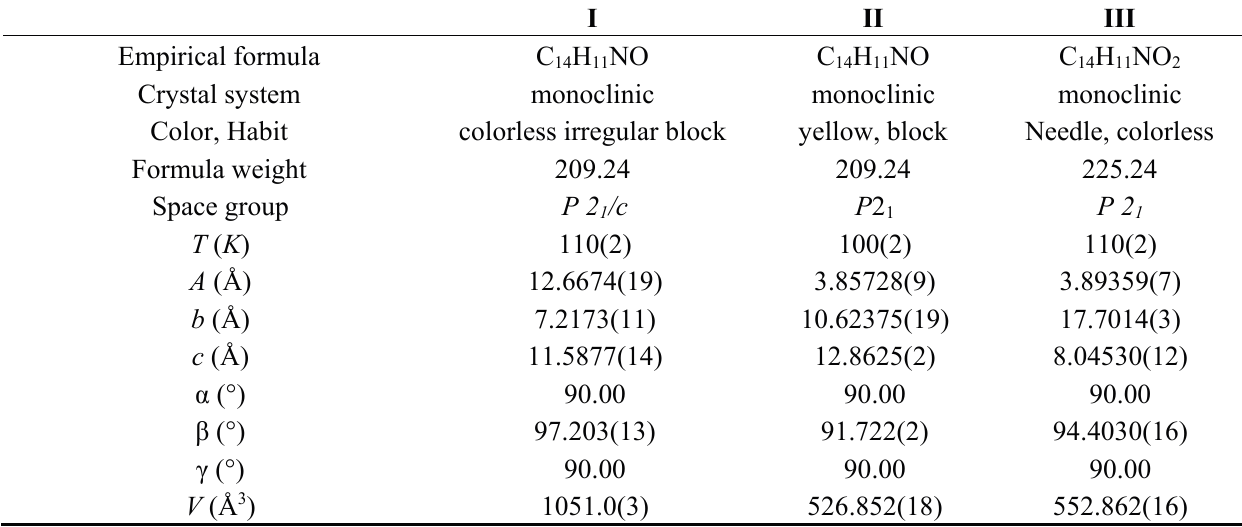
Figure 1. Molecular structures of I , II and III . The displacement ellipsoids are drawn at the 50% probability level and H atoms are shown as small spheres of arbitrary radii. Table 1. Crystallography Data for I , II and III